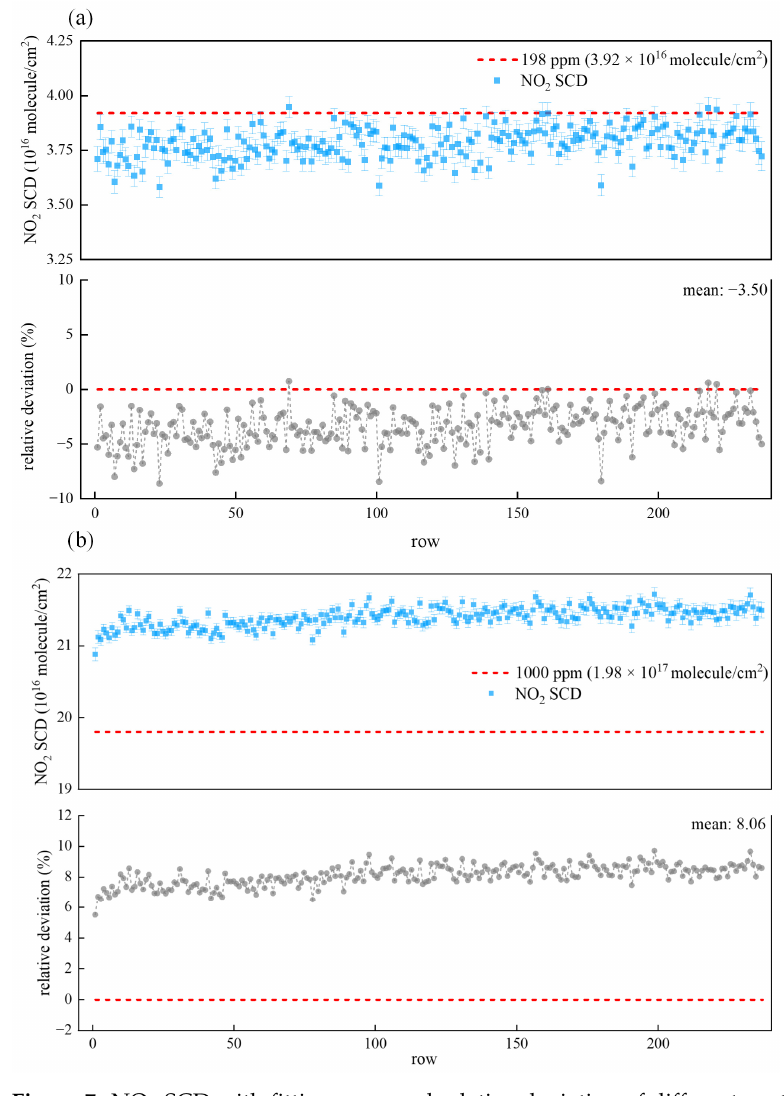
Figure 7. NO 2 SCD with fitting error and relative deviation of different spatial pixels of EMI-NL limb module with tungsten halogen lamp and NO 2 sample gas concentrations of: ( a ) 198; and ( b ) 1000 ppm.